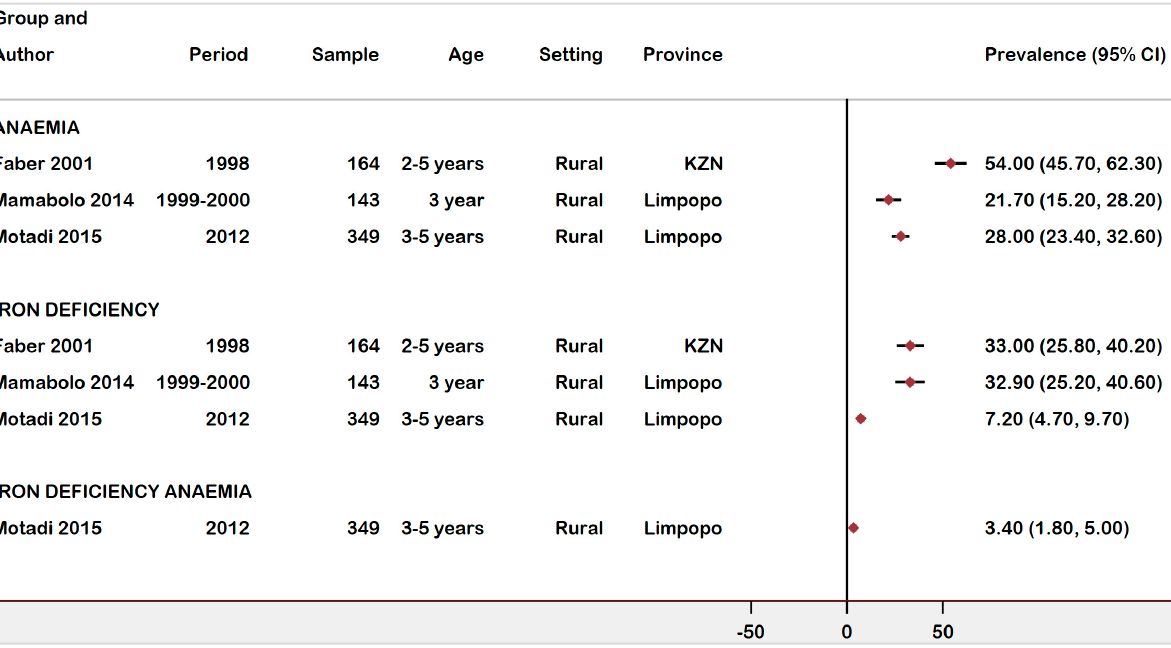
Figure 5. Forest plot of prevalence of anaemia, ID, and IDA in children age 24 months–59 months in South Africa, 1997-2021.